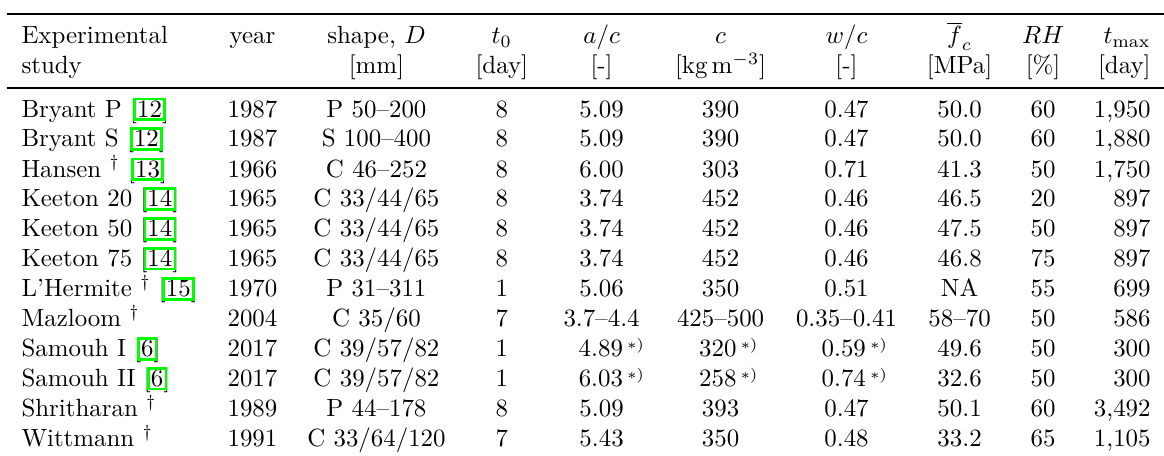
Table 1. Details of the experimental setup of the selected shrinkage experiments. The specimen shape is either a prism (P), cylinder (C), or a slab (S), D is the effective thickness, t 0 is the onset of drying, c , w , a is the cement, water and aggregates content, respectively, in the concrete mixture. The average compressive strength on cylinders at 28 days is denoted f , RH is the ambient relative humidity, and t max is the duration of the experiment (i.e. drying c duration). In Samouh I and II, asterisks ∗ ) indicate that c corresponds to the content of OPC, not to the total amount of cementitious material, the data with symbol † are adapted from the NU database [16].